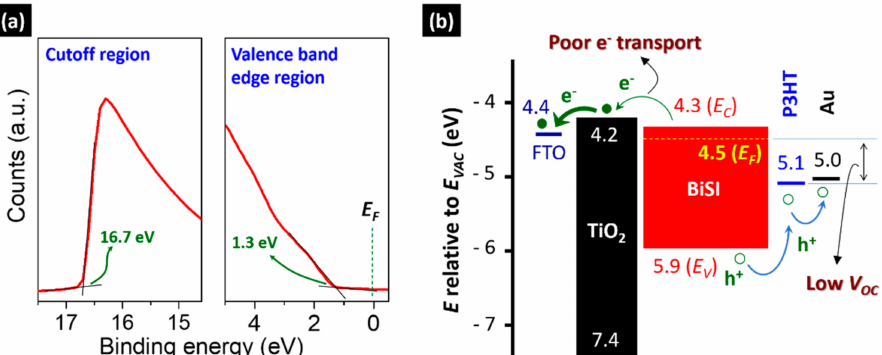
Figure 5. ( a ) UPS spectra of the cut-o ff and valence band edge region for the BiSI nanorods film, and ( b ) the derived energy-level band diagram. For comparison, a conducting oxide (FTO), ETL (TiO 2 ), HTM (P3HT), and electrode (Au) were drawn based on a previous study